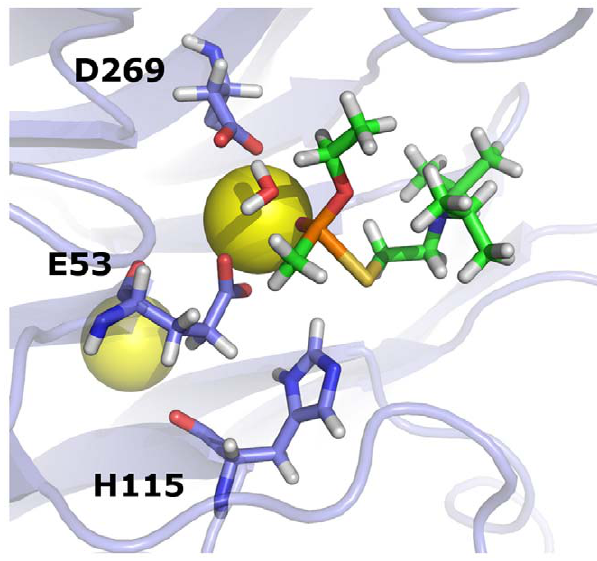
Figure 3. Scatter plot of experimental vs. predicted activity for the top-scoring set of variables (D269 mechanism, d s =2.00 A˚, d t =2.25 A˚, ITASSER/SMD structure, VX ts ( 2 ) enantiomer, and Gasteiger charges). This dataset has a Pearson correlation of 0.767 (p , 10 2 4 )